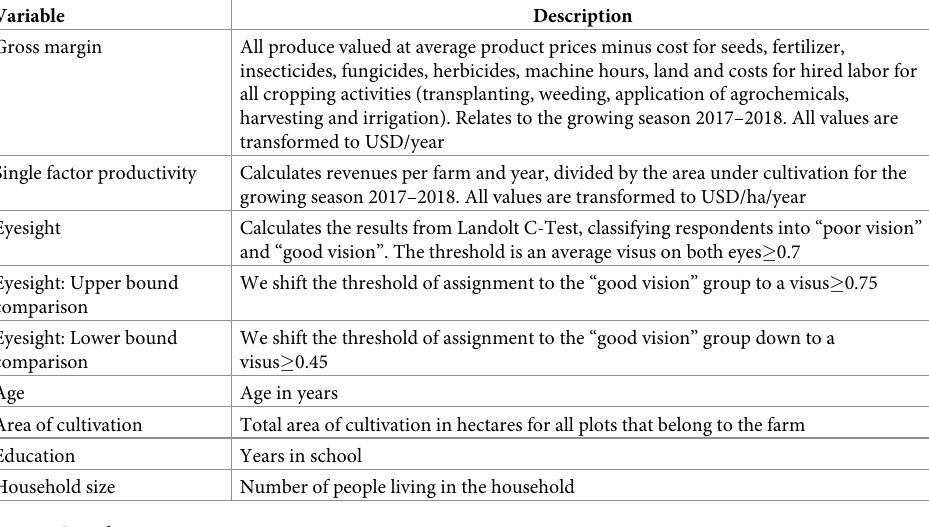
Table 1. Data description for selected